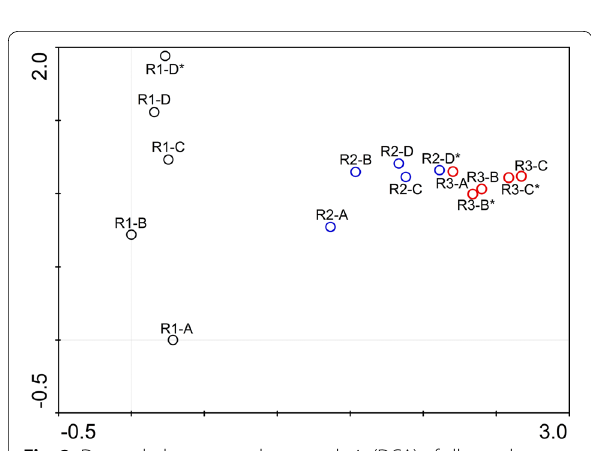
Fig. 2 Detrended correspondence analysis (DCA) of all samples based on phylum level